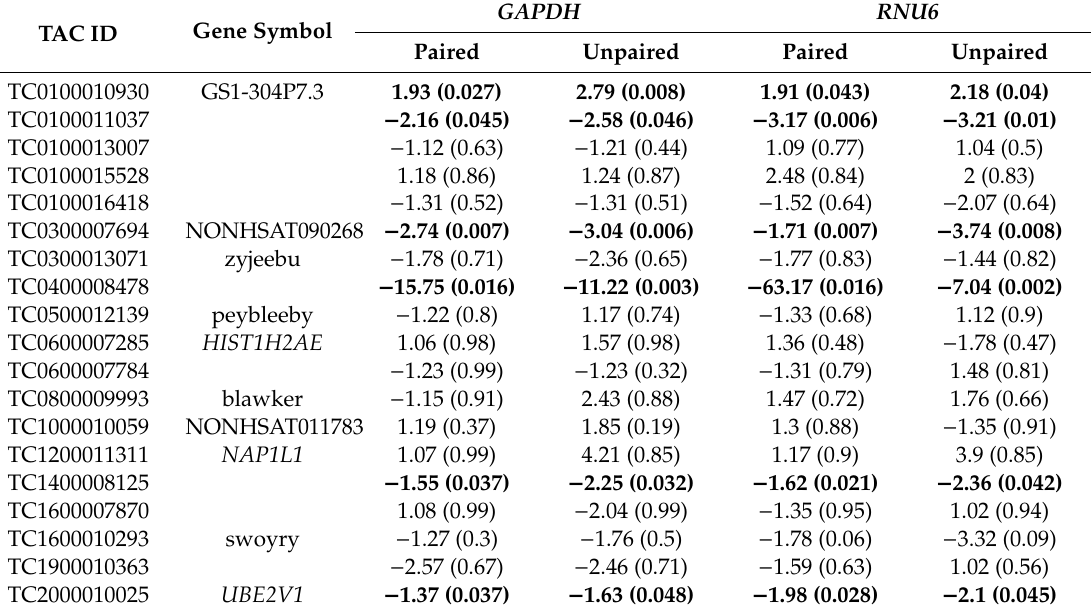
Table 1. Real-Time PCR results. For each transcript, TAC ID, gene symbol (where available), median fold change and p- value (between brackets) are shown for each endogenous control ( GAPDH and RNU6 ) and for both paired and unpaired analyses. Significant values are highlighted in bold. TAC: Transcriptome Analysis Console; GAPDH : glyceraldehyde-3-phosphate dehydrogenase; RNU6 : RNA, U6 small nuclear